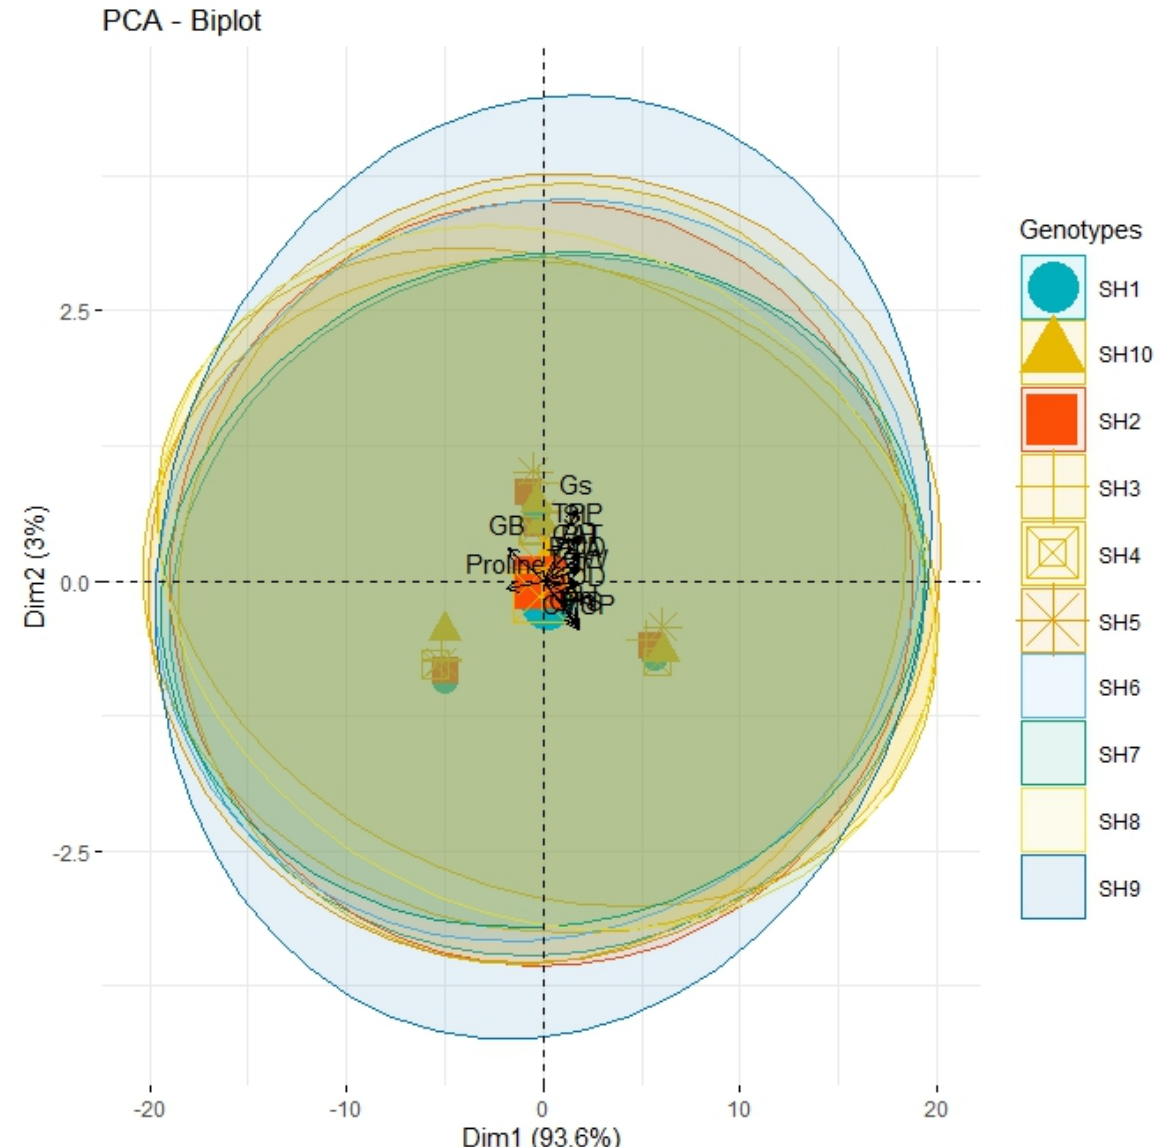
Figure 3. PCA with no scatter circle indicating analogous impact of synthetic SH wheat genotypes on proximity association of physiological, biochemical, and agronomic traits. Pn; photosynthesis, Gs; stomatal conductance, Tr; transpiration rate, CMSP; cell membrane stability percentage, GB; glycine betaine, SOD; superoxide dismutase, POD; peroxidase, CAT; catalase, FLA; flag leaf area, PH; plant height, TPP; tiller per plant, SL; spike length, GPS; grains per spike, TGW; thousand grain weight.